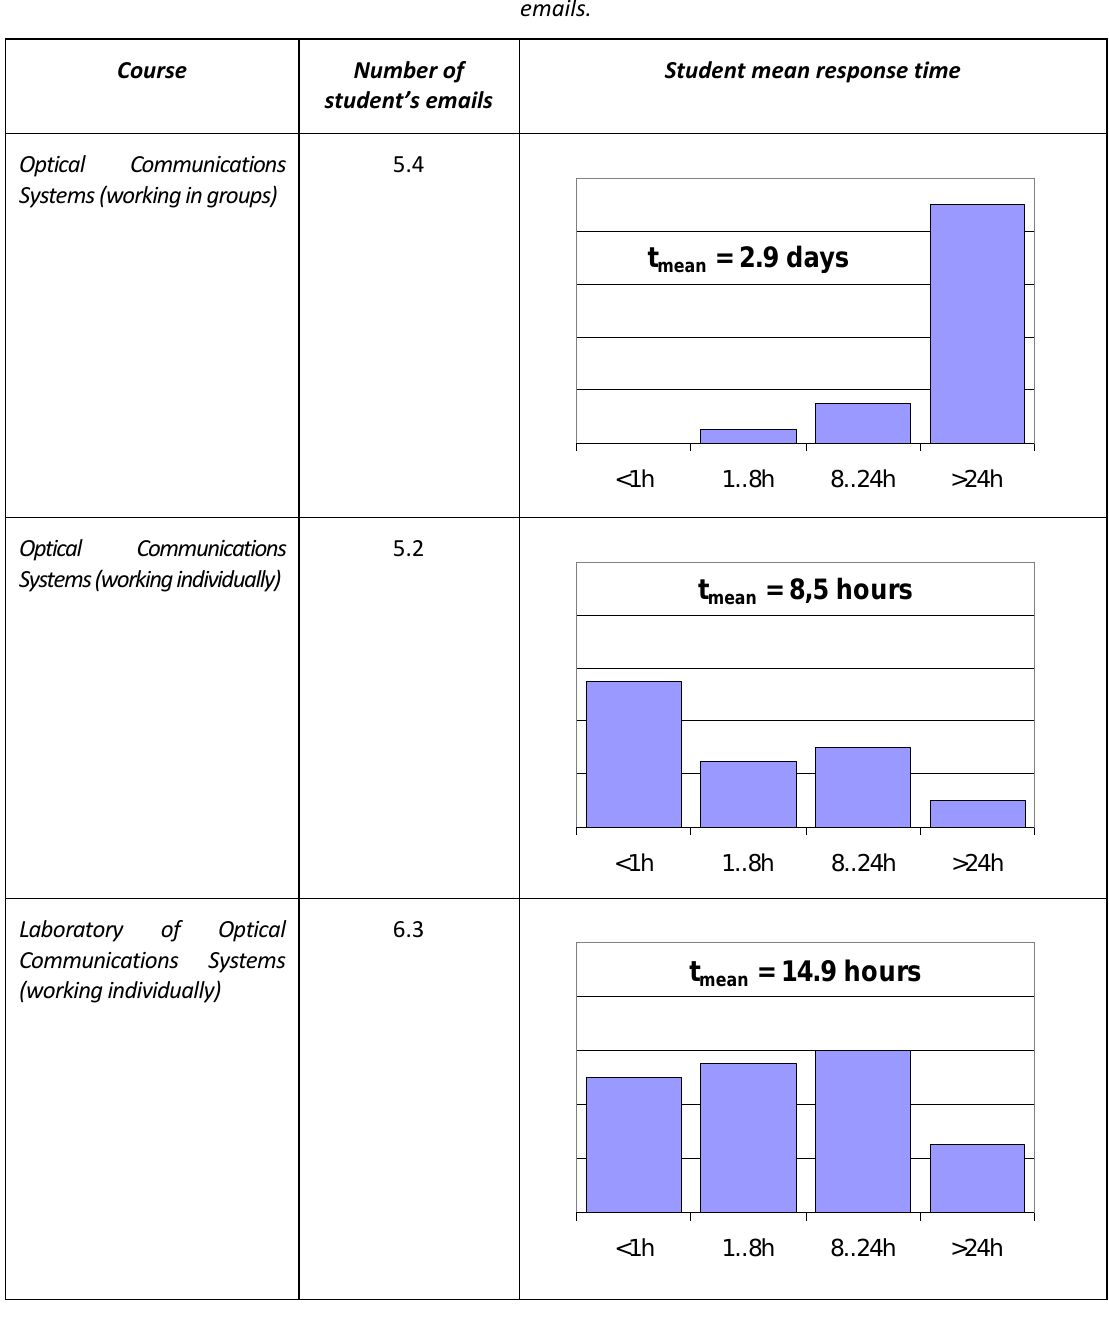
Table 1: Mean number of emails to complete the activity and mean response time to the instructor’s